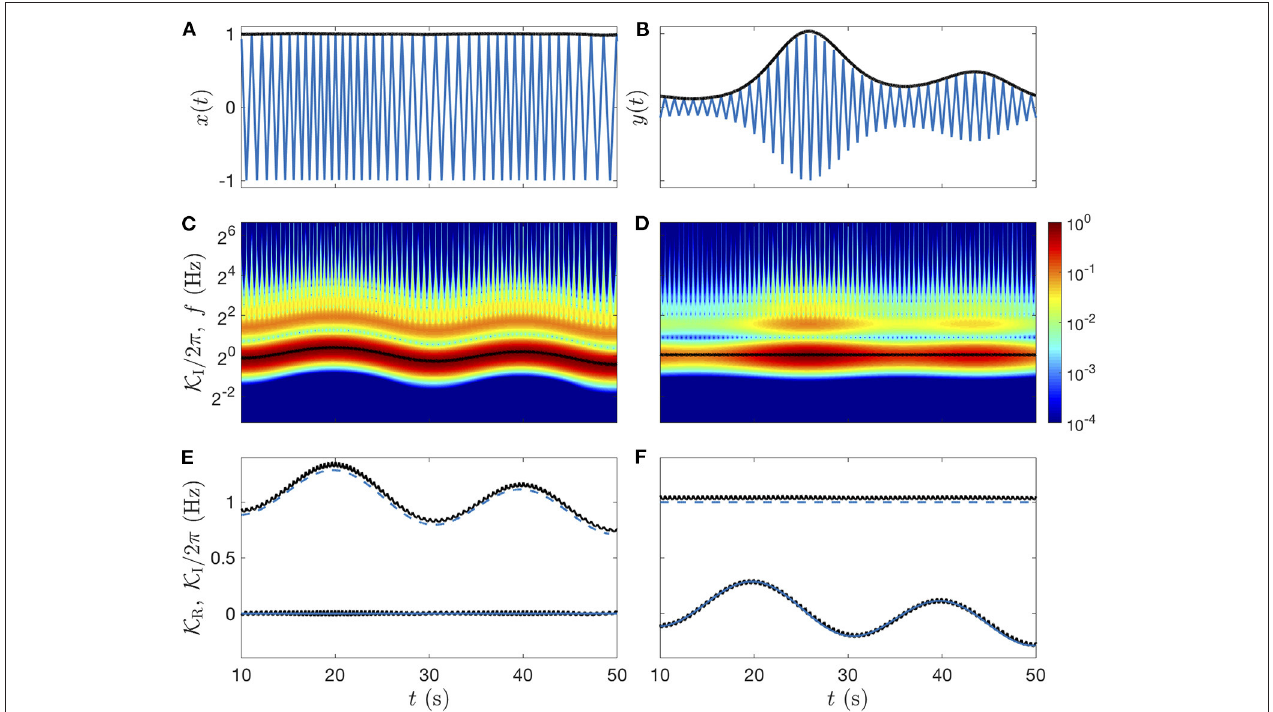
FIGURE 5 | Idealized modulated signals: triangle waves. (A) Signal x ( t ) of modulated frequency and constant amplitude. (B) Signal y ( t ) of modulated amplitude and constant frequency. In (A,B) the amplitude modulation (estimated from Equation 12) is plotted in black lines. (C,D) Color-coded illustration of the amplitudes of the signal CWTs (twice the modulus), with their estimated frequency modulation K I ( t ) / 2 π (black lines). (E,F) Real and imaginary parts of the complex rates (Equation 8): K R ( t ) and K I ( t ) / 2 π in black lines, are compared to the ideal values of the instantaneous frequency (blue dashed line centered to 1 Hz) and exponential rate (blue line centered to 0 Hz), see definitions in Equations (10) and (11). The Grossmann wavelet of quality factor Q 5 is used for the CWTs and for the rates computations. =